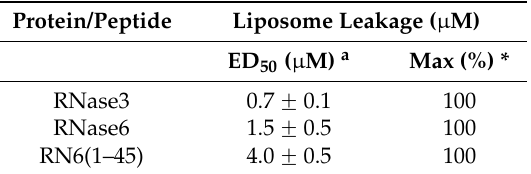
Table 3. Liposome leakage activity of RNase3, RNase6 and RN6(1–45).